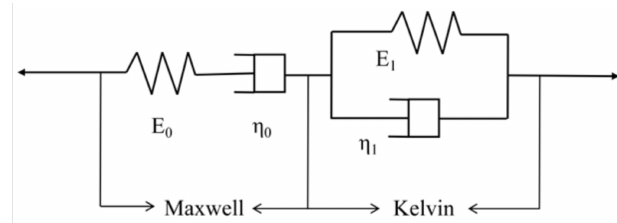
Figure 9. Four-element model.